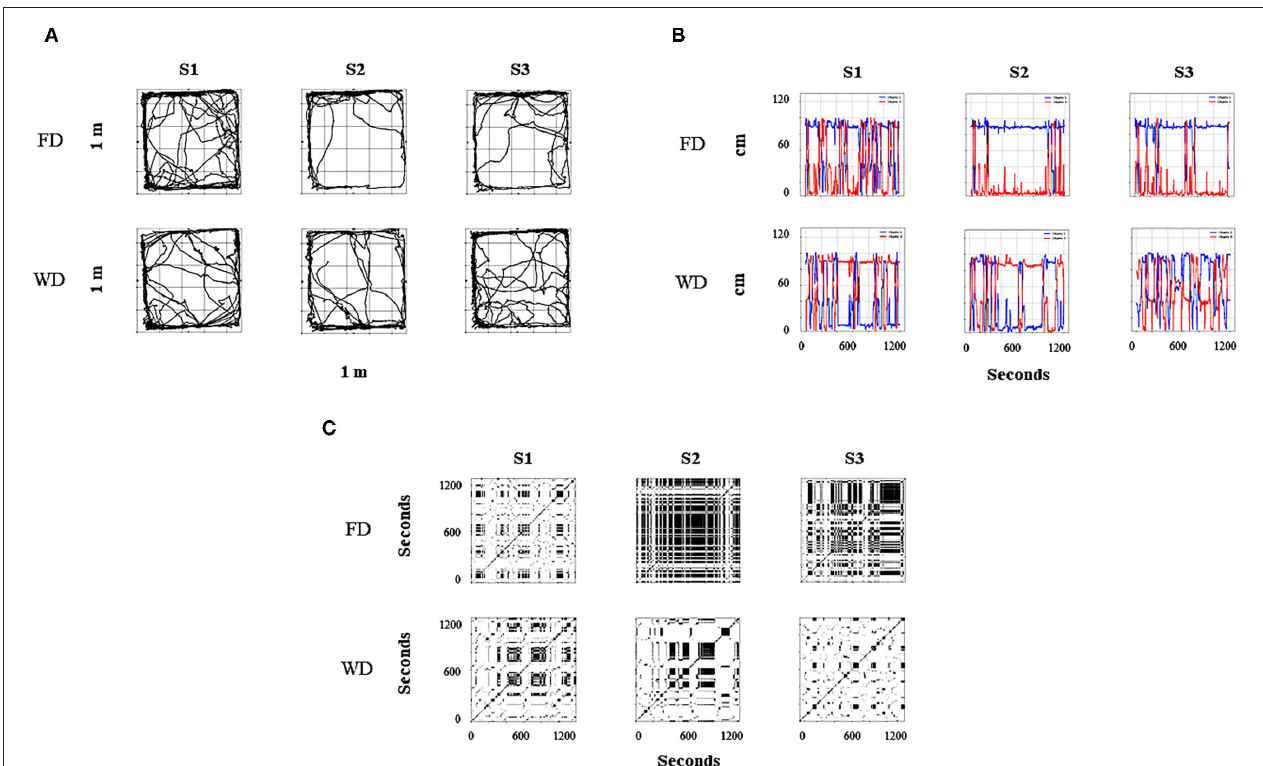
FIGURE 8 | Representative within-subject results for all sessions of the behavioral continuum for one rat (R5). Each column depicts a session, and rows depict deprivation conditions (FD and WD, respectively). (A) shows the routes of the rat in a bidimensional representation of the experimental chamber; red circles represent food dispenser location, and blue circles represent water dispenser location. (B) depicts the distance to the dispensers (Y-axis) moment to moment (X-axis); the red line represents the distance to food dispenser; the blue line represents the distance to water dispenser. Finally, (C) shows recurrence plots; this changes regions of each rat (in a matrixial configuration of 10 × 10 virtual zones) as the session